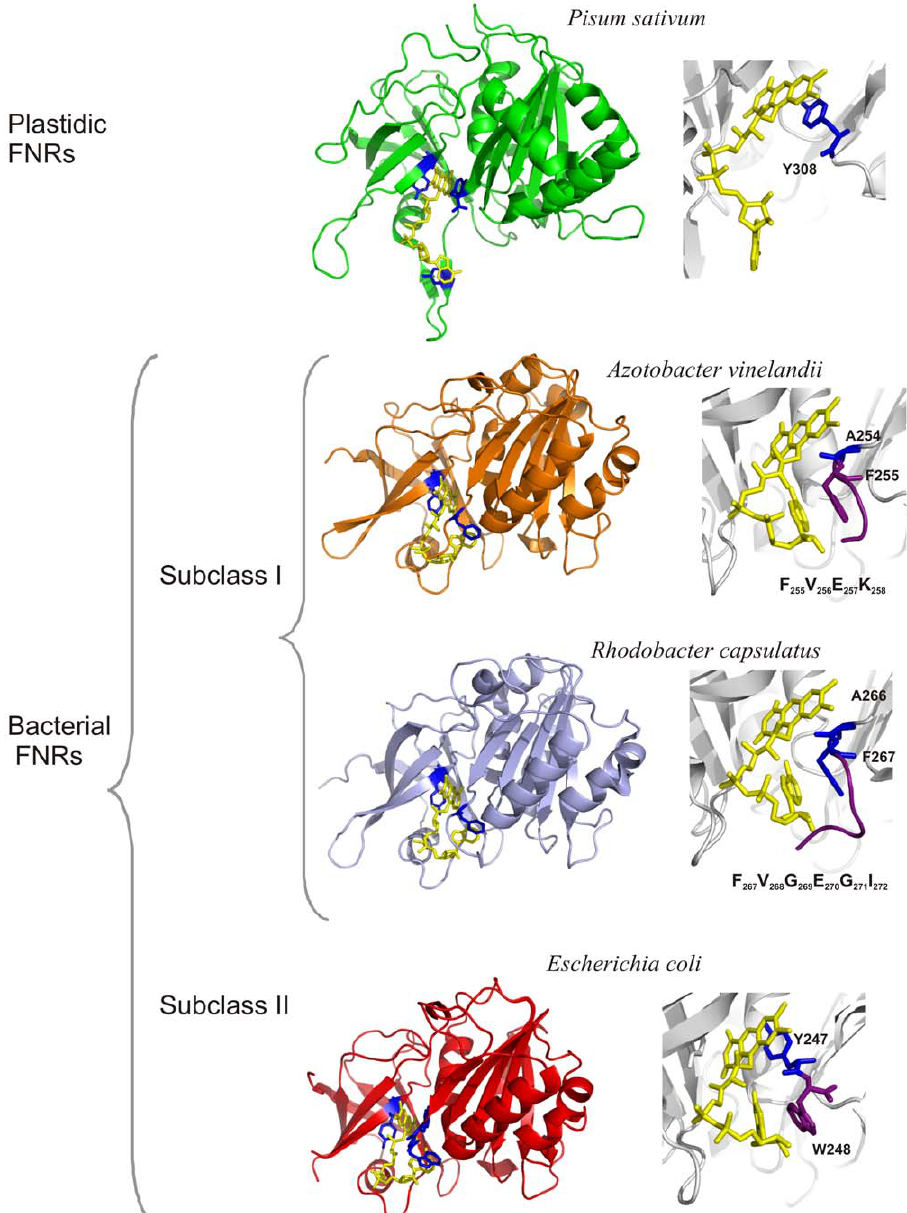
Figure 1. Classification of plant-type FNRs according to structural features. Plant-type FNRs are classified as plastidic and bacterial FNRs [21]. Structures of representative prototypes of the plastidic and the bacterial groups are shown. Bacterial-type FNRs are subdivided into two subclasses, subclass I and subclass II. FNRs from Azobacter vinelandii and Rhodobacter capsulatus belong to subclass I; however, they differ in length and sequence of the carboxy-terminal region upstream of the alanine that faces the isoalloxazine of FAD. A view of the environments of the different prosthetic groups and the sequences of the carboxy-terminal extensions are shown to the right of each enzyme structure. FNRs from Pisum sativum (1qg0), E. coli (1fdr), A. vinelandii (1a8p) and R. capsulatus (2bgj) were used as model proteins. Figures were generated using PyMol. Available: http:// pymol.sourceforge.net/.